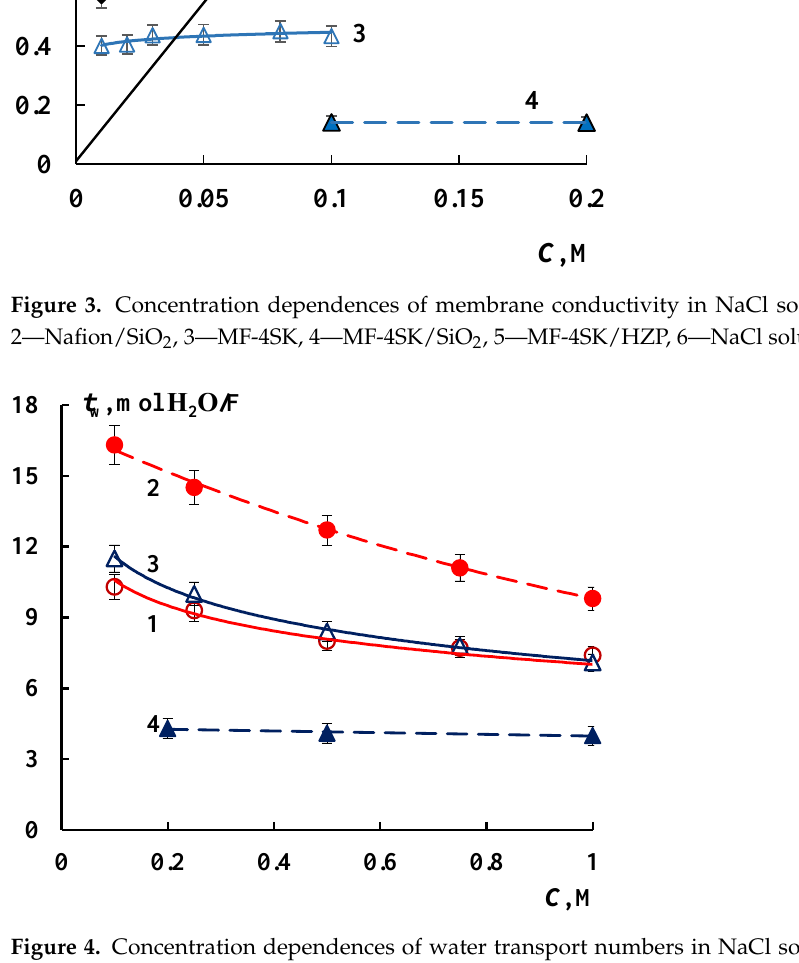
Figure 4. Concentration dependences of water transport numbers in NaCl solutions: 1 — Nafion, 2 — Nafion/SiO 2 , 3 — MF-4SK, 4 — MF-4SK/SiO 2 .